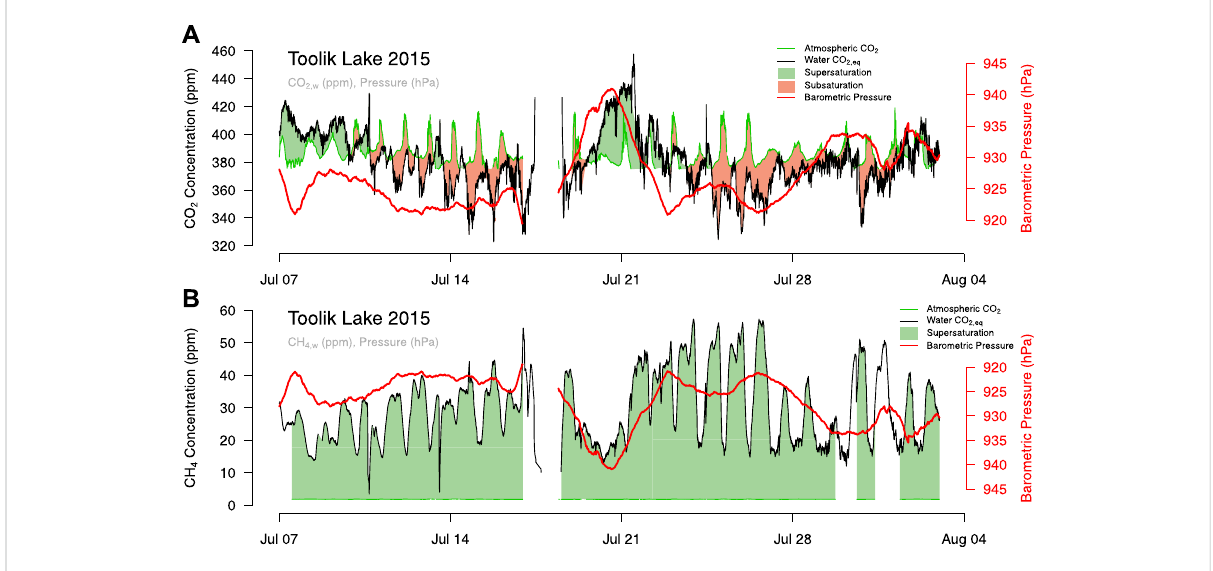
FIGURE 1 Timeseries of (A) CO 2 concentrations and (B) CH 4 concentrations in the atmosphere (green lines) and the surface water (black lines) during the ice-free seasons2015.Supersaturationofthesurfacewater isshown withagreen areabetweenthetwoconcentrations, andsubsaturationisshown with a red area. In addition, barometric pressure (bold red lines) are shown; note axes at right, and the inversed barometric pressure axis in (B)